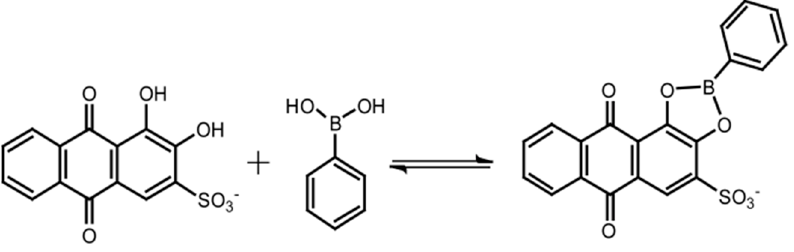
Figure 4. Formation of boronate ester ARS-PBA in the film.